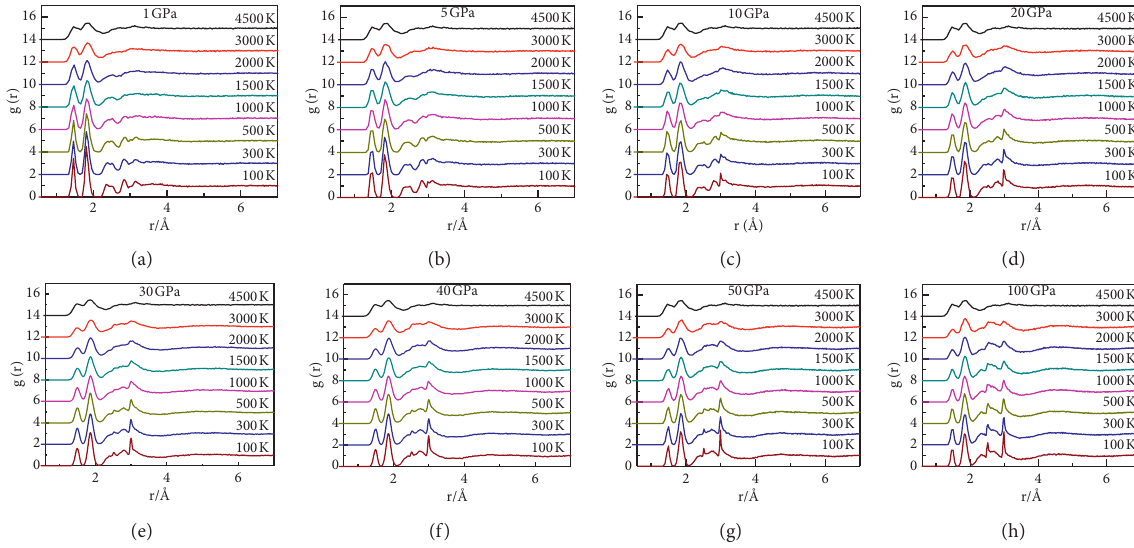
Figure 3: Change in RDF with the temperature of SiC under different pressures.